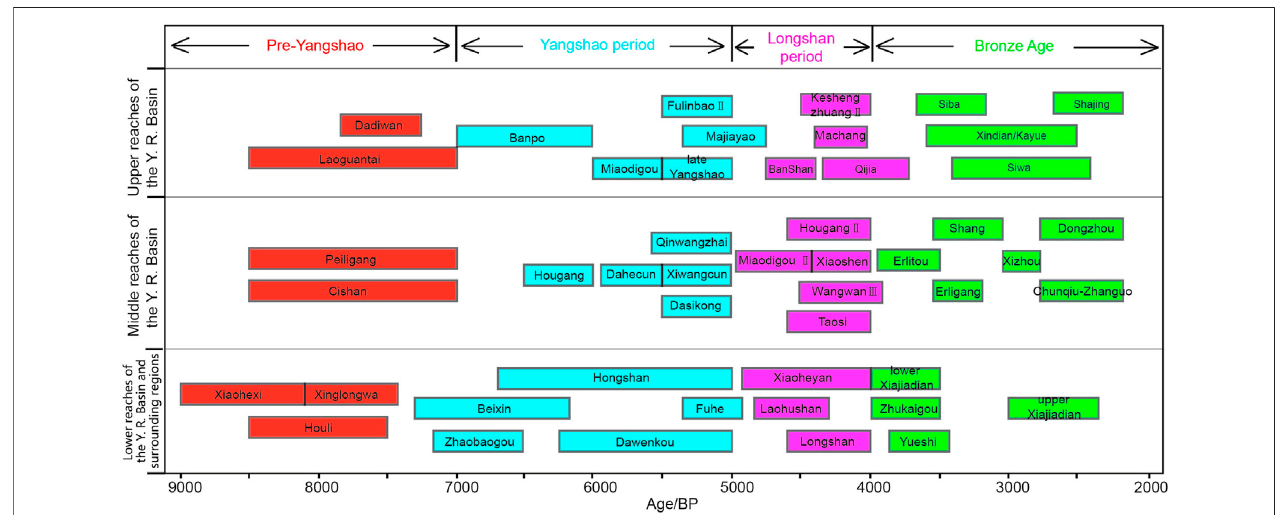
FIGURE 1 | Culture sequence in the Yellow River basin and surrounding